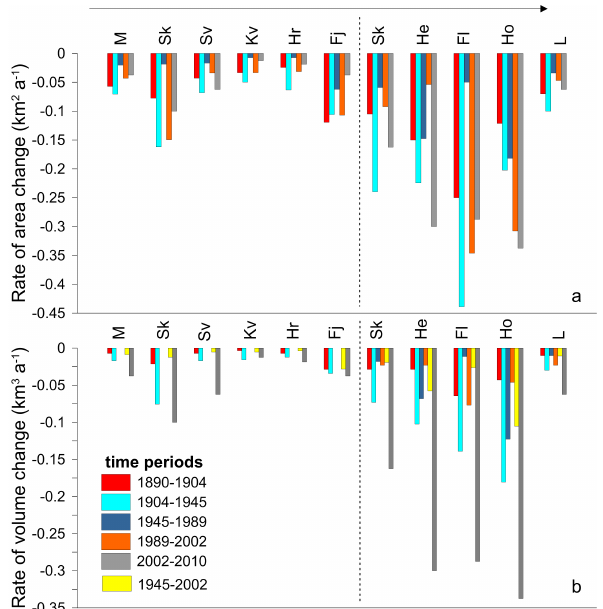
Figure 9. Rate of area (a) and volume (b) change of the outlet glaciers (from west to east) during different time periods of the last 120 years. The first few letters of each glacier name are shown at the top, glaciers represented from west to east. The dotted line separates the outlets of Öræfajökull and the eastern